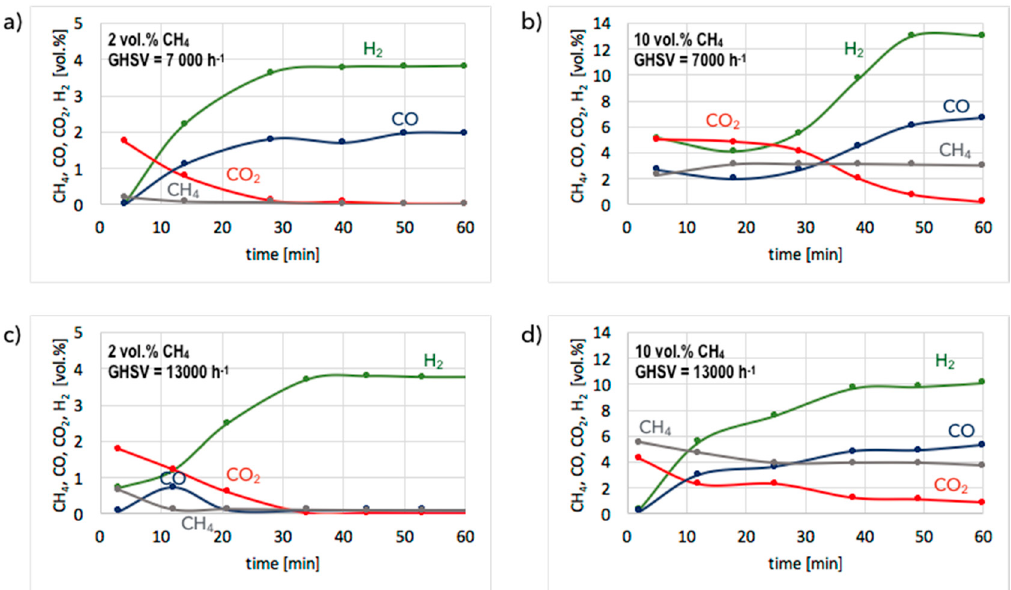
Figure 3. Gas composition at reactor outlet during tests of CH 4 decomposition on unreduced Ni/CeZrO 2 at gas hourly space velocity (GHSV) = 7000 h − 1 ( a , b ) and 13,000 h − 1 ( c , d ). Reaction mixture: 2 vol.% CH 4 /Ar ( a , c ) and 10 vol.% CH 4 /Ar ( b , d ).